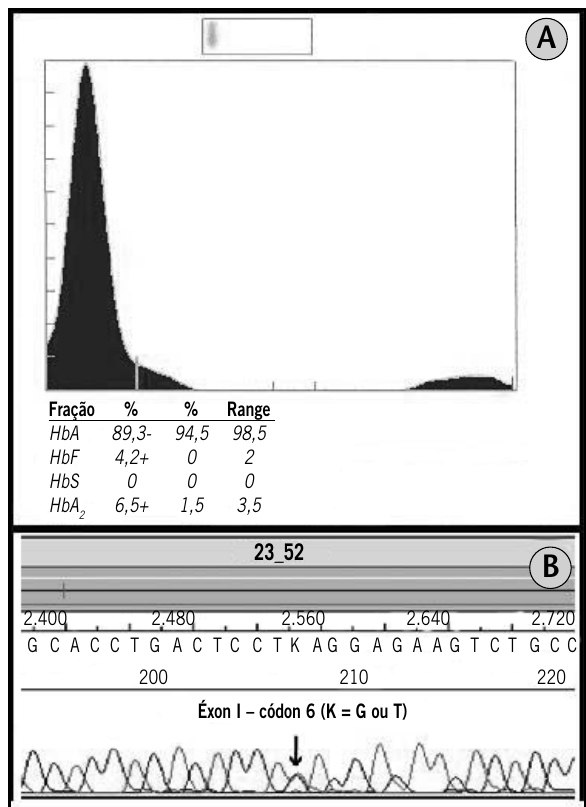
Figura 4 – (A) Eletroforese de Hb em meio alcalino, acompanhada de leitura densito- métrica da amostra, demonstrando aumento das frações de HbF e HbA molecular de sequenciamento evidenciando mutação no códon 6 (G → T) (seta) Hb: